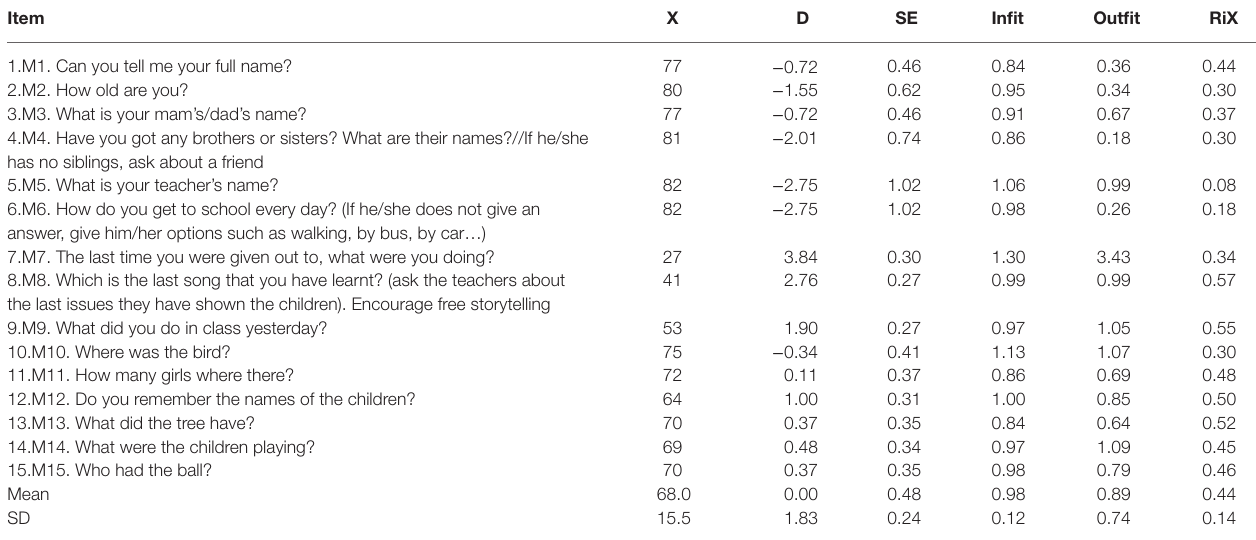
TABLE 4 | CAPALIST-memory. Item